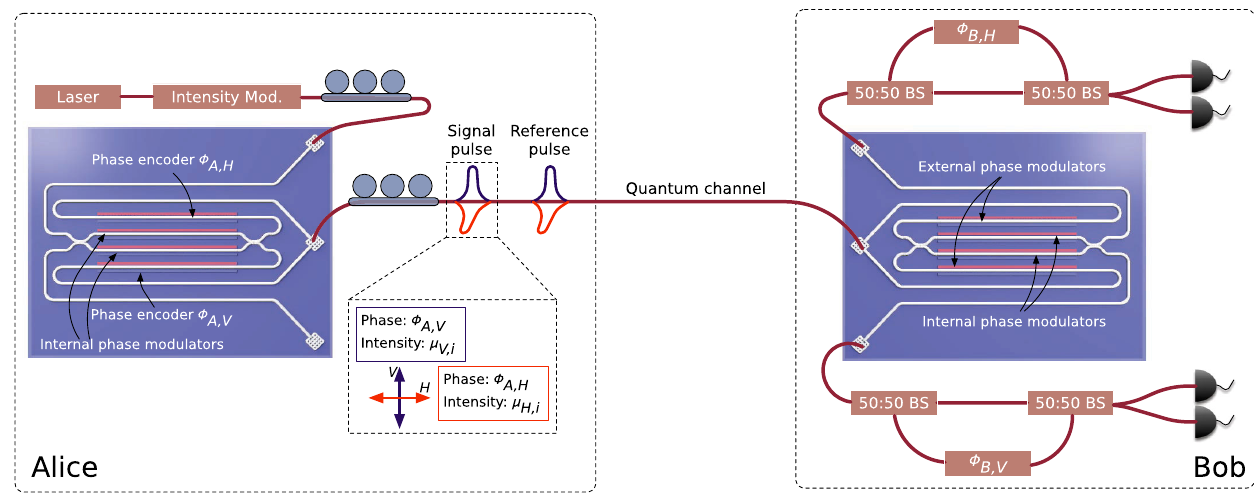
FIG. 4. Schematic diagram of polarization-mode-efficient phase-encoded BB84 QKD which encodes information in both polar- izations using the silicon photonics QKD encoder. Alice encodes information in both polarization modes using a single silicon photonics encoder. Bob, on the other hand, uses another copy of the silicon photonics chip to undo the polarization unitary transformation of the channel. At each output, he detects using an unbalanced Mach-Zehnder interferometer terminated by two single-photon